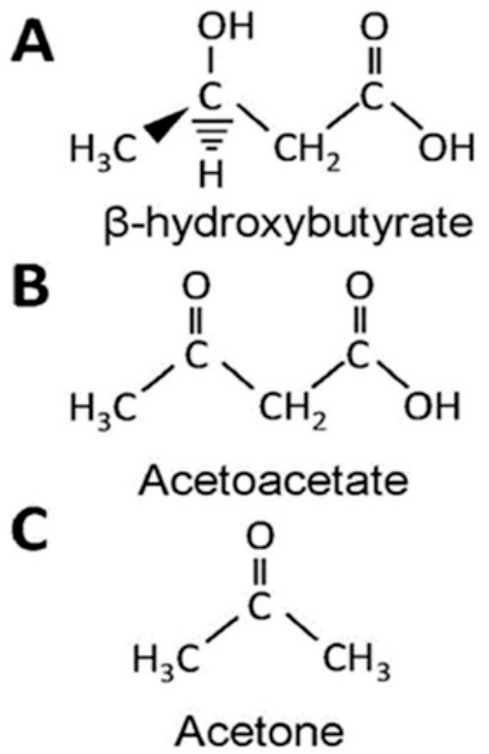
Figure 1. Ketones. A = β -hydroxybutyrate; B = Acetoacetate; C = Acetone. The common goal of all KDs is to induce the production of ketones in the liver through the beta-oxidation of free fatty acids with the aim of mimicking a state of fasting, but without depriving the body of the calories needed to support growth and development [32,33]. The ke- tones that are generated, acetoacetate and BHB, then enter the bloodstream and are transported to metabolically active tissues, i.e., skeletal muscle, heart, and brain, where they are used for energetic purposes [29], whereas acetone, produced by the spontaneous decarboxylation of acetoacetate, is rapidly eliminated through the lungs and urine (Figure